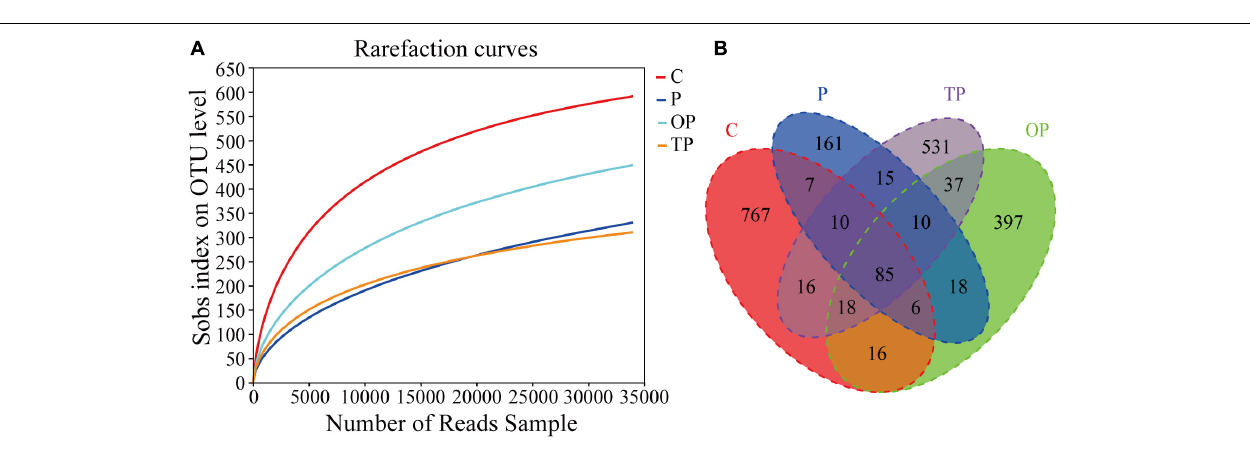
FIGURE 3 | Rarefaction curves and Venn diagram analysis of intestinal microbiota for control and PHB treatments. (A) Rarefaction curves analyses of the different treatments and (B) Venn diagram. C (control): basal diet; P: basal diet supplementation with 0.5% PHB; OP: basal diet supplementation with 1% PHB; TP: basal diet supplementation with 3%